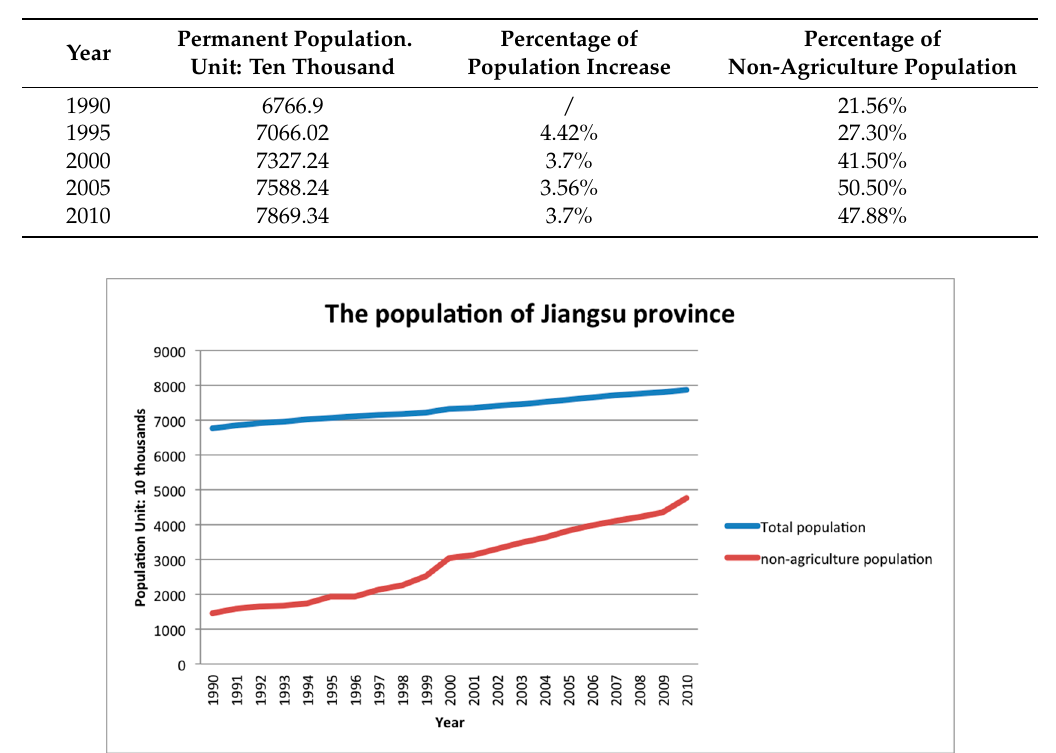
Table 8. Population of Jiangsu province.